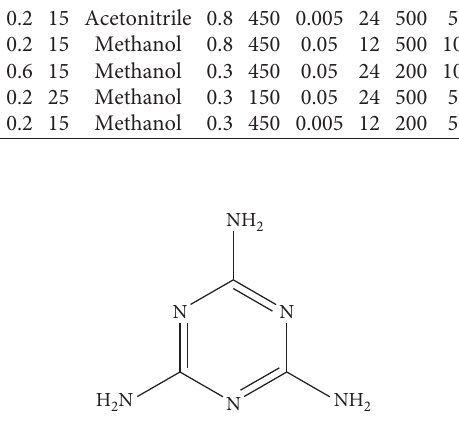
Scheme 1: Structure of melamine